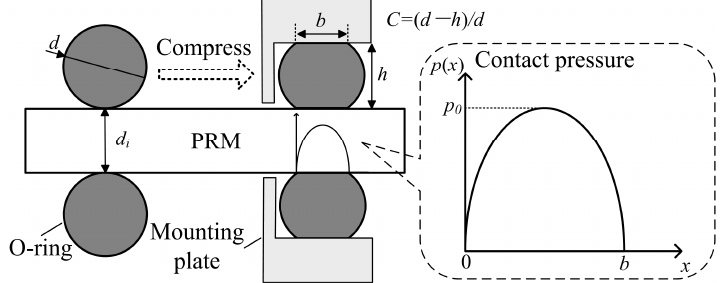
Figure 4. Contact state between the O-ring, planetary reducer motor (PRM), and L-groove.